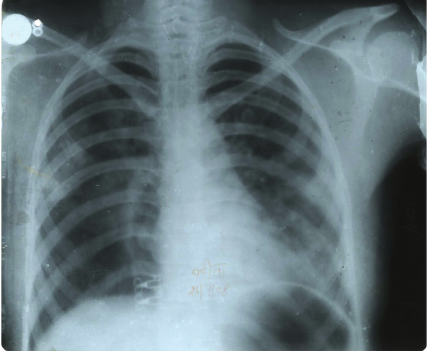
Figure 1: CXR PA showing nonspecific infiltration.